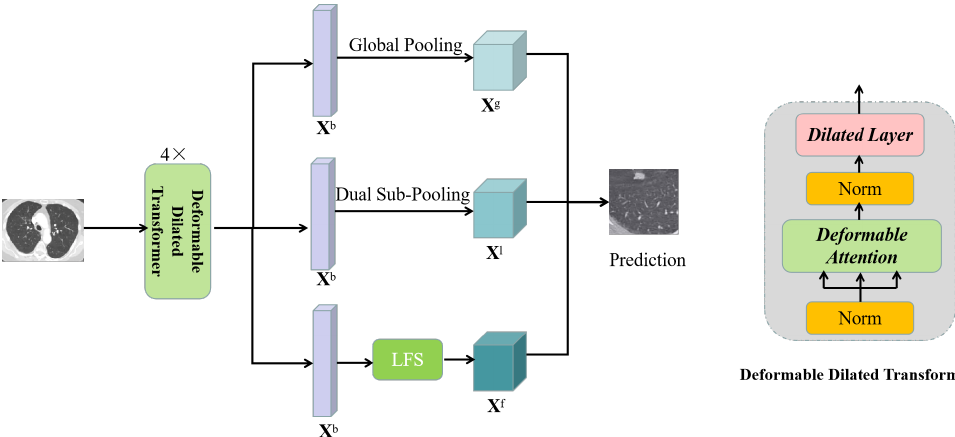
Figure 3. Illustration of the proposed Multi-Granularity Dilated Transformer. We use the proposed Deformable Dilated Transformer as our backbone and then leverage the global pooling, dual sub- pooling, and LFS to jointly capture multi-granularity